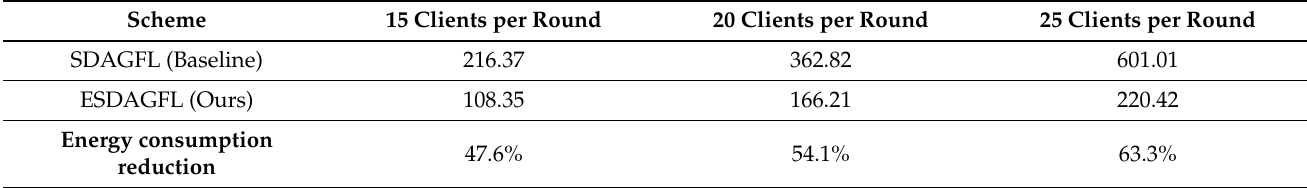
Table 6. Energy consumption [KJ] with a different number of clients per round evaluated on the FMNIST-clustered